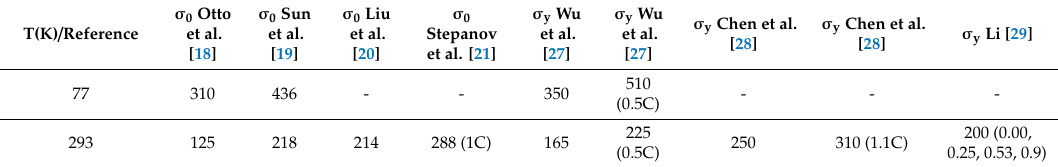
Table 2. Lattice resistance, σ 0 , from yield strength-grain size plots, and yield strength, σ y , (both in MPa) for large grained equiatomic CoCrFeMnNi with and without carbon (at. % C indicated in parentheses) from the papers